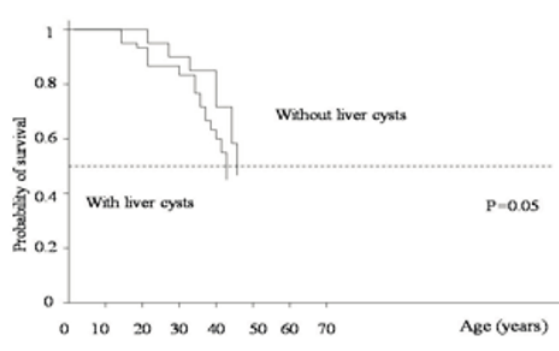
Figure 2. Renal survival in female patients with and without liver cysts